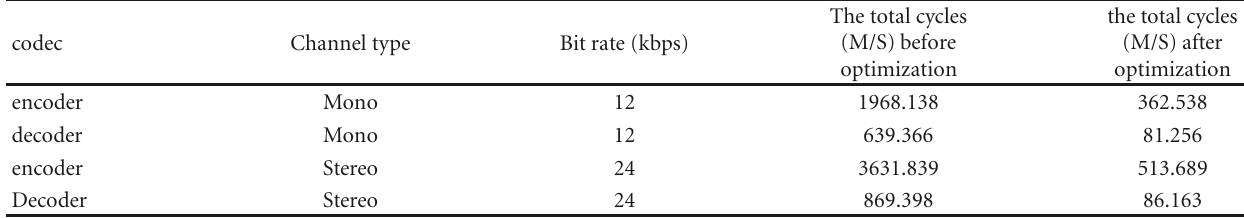
Table 7: The AVS-M codec complexity comparison of before and after optimization.